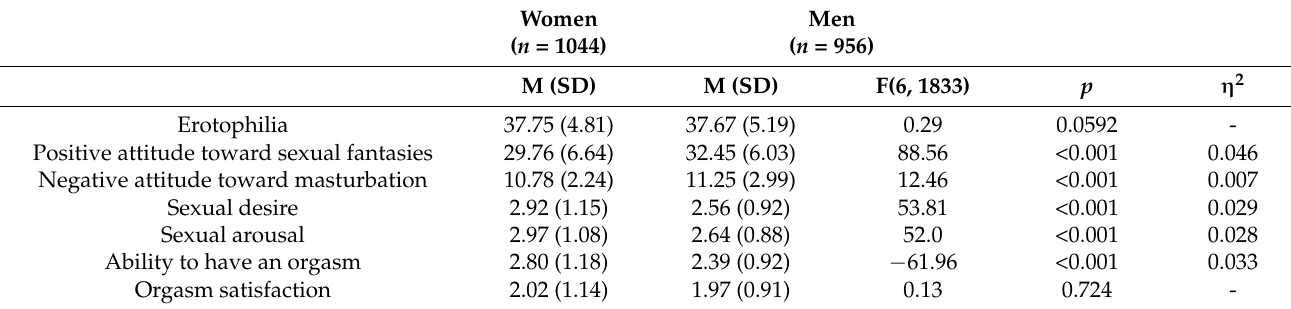
Table 2. Comparison of sexual attitudes and sexual function between women and